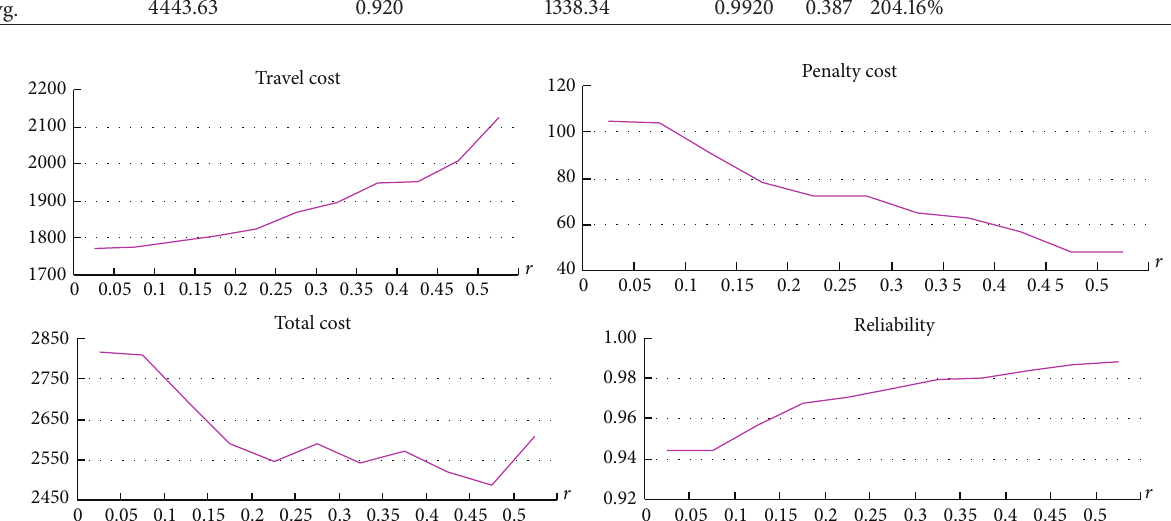
Figure 4: The changing trends of travel costs, penalty costs, total costs, and reliabilities for all values of 𝑟